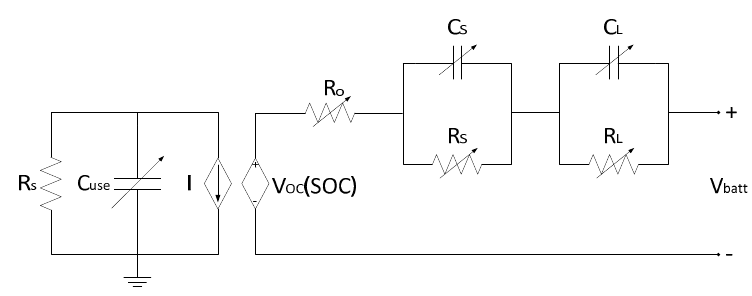
Figure 3. Lam and Bauer battery circuit model.